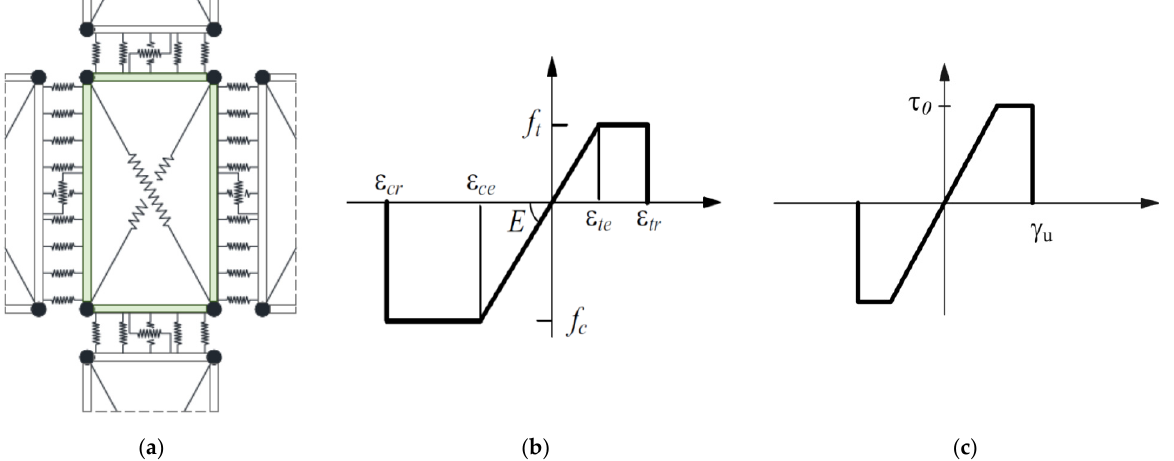
Figure 3. ( a ) 2D macro-element adopted in the 3D Macro software. Constitutive laws adopted in the macro-element model for: ( b ) tension/compression and ( c ) shear.